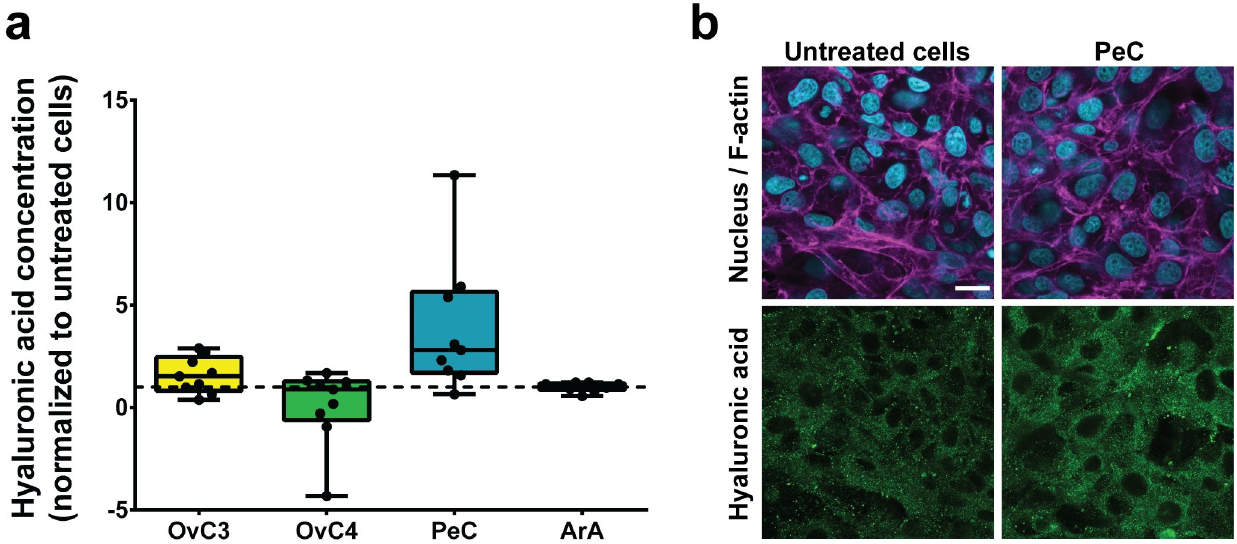
Fig 3. Hyaluronic acid concentration of exposed MeT-5A cells compared to untreated cells. a) HA secretion of cells exposed to ascites normalized to untreated samples (dotted line); data are presented as median ± Min/Max, n = 3. b) Fluorescence images of untreated MeT-5A cells and exposed to PeC. Cell nuclei are displayed in cyan, F-actin in magenta, and HA in green. Scale bar is 20 μ m.